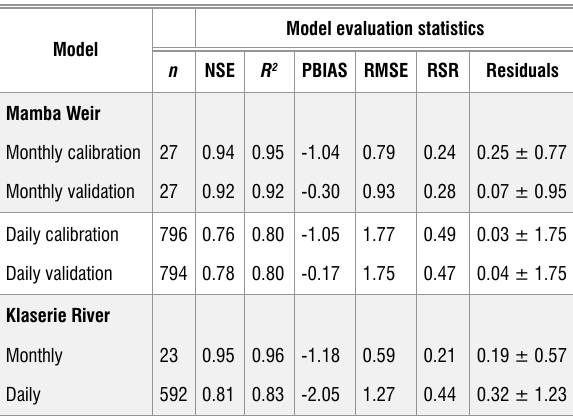
Table 1: Evaluation statistics for calibration and validation models of monthly and daily water temperatures at Mamba Weir Model evaluation Model